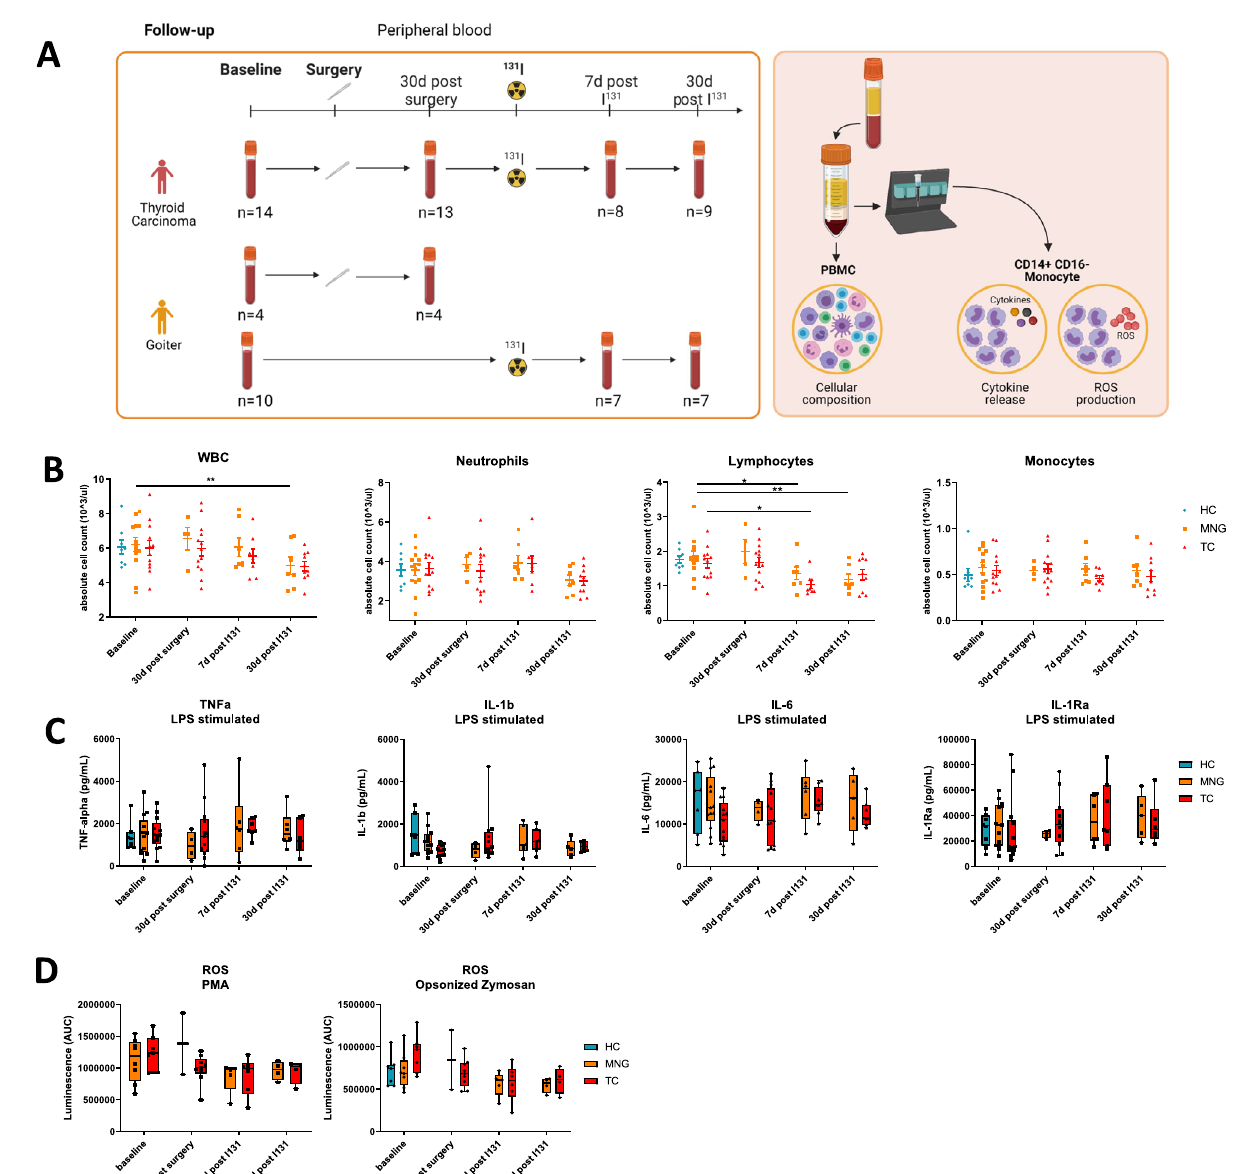
Fig. 4 | Effect of treatment on functional phenotype of peripheral blood clas- sical monocytes and circulating in fl ammatory mediators in peripheral blood plasma. A Study Design Follow-up Measurements: Peripheral blood was collected from TC and MNG patients before treatment (baseline), 30 days after surgery, 7daysand30daysaftertreatmentwithradioactiveiodine.Illustrationcreatedwith BioRender.com. B Differential cellcountsin whole blood.(HC n =8,MNG n =4 – 13, TC n =8 – 13). Mean±SEM. Mixed effects model (repeated measures two-way ANOVA with missing values) followed by Bonferroni correction. Each time point wascomparedtothebaselinetimepoint,asnotallstudyparticipantsreceivedboth treatments. Adjusted p values: MNG baseline vs. 7d post I131 p =0.011, baseline vs. 30dpostI131 p =0.003;TCbaselinevs.7dpostI131 p =0.034. C Cytokinereleaseof CD14 + CD16 - classical monocytes after 24h stimulation with TLR4 ligand LPS. (HC